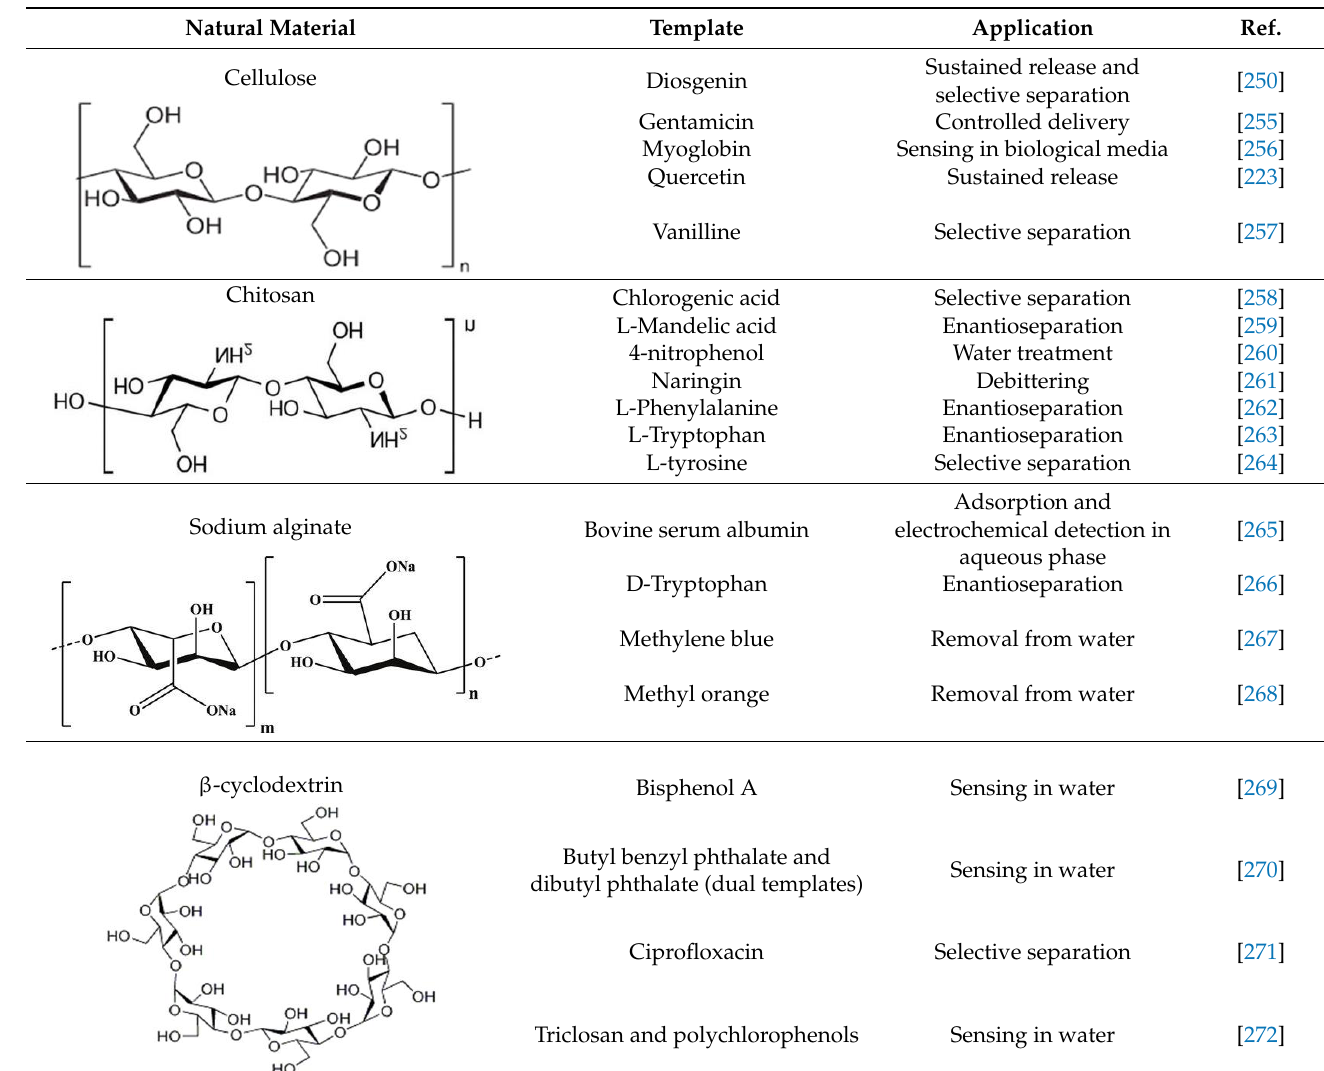
Table 2. Some examples of natural materials used in the production of MIMs.